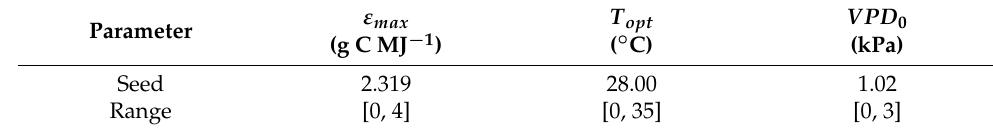
Table 1. Seed and boundary conditions of each parameter used for LUE model optimization.